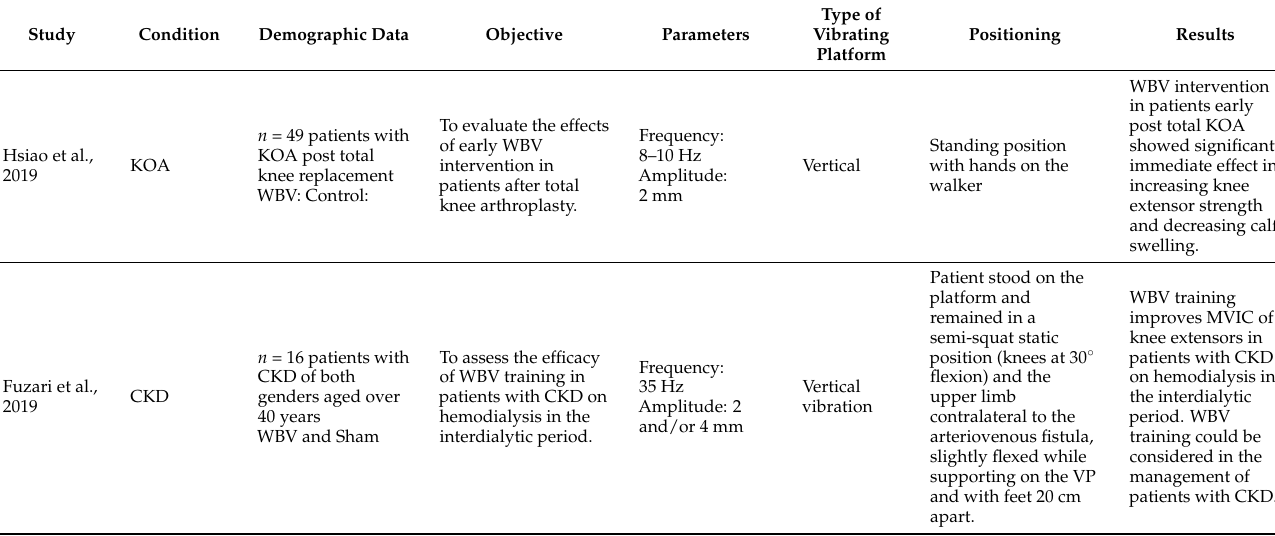
Table 2. Different populations submitted to WBV exercise, with symptoms also observed in the COVID-19 patients: muscle